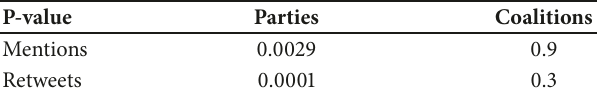
Table 6: P values of the paired t-test performed in the assortative mixingtimeseriesofpartiesandcoalitions.Thetesthasbeencarried out by taking each time series of 2015 and coupling it with its counterpart of 2016.